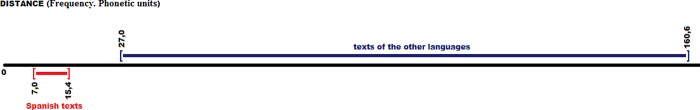
Distances between the Spanish or Castilian (average value) with all the texts of all the languages (phonetic units).